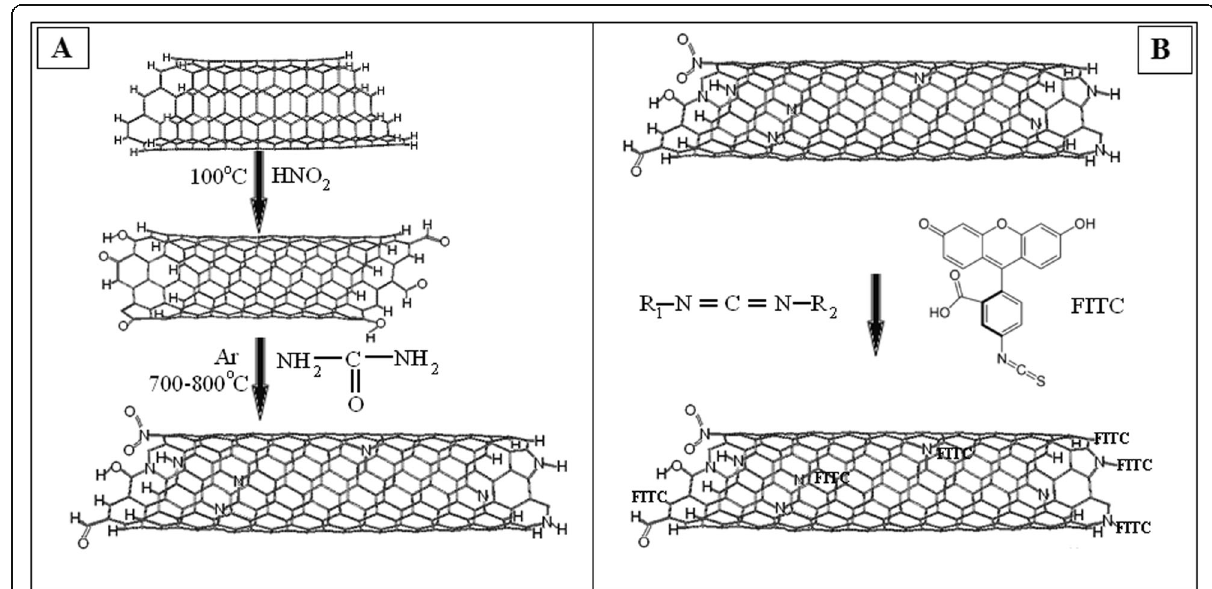
Fig. 2 a Scheme of reaction of CNTs with urea. b Scheme of the functionalization of the CNTs by